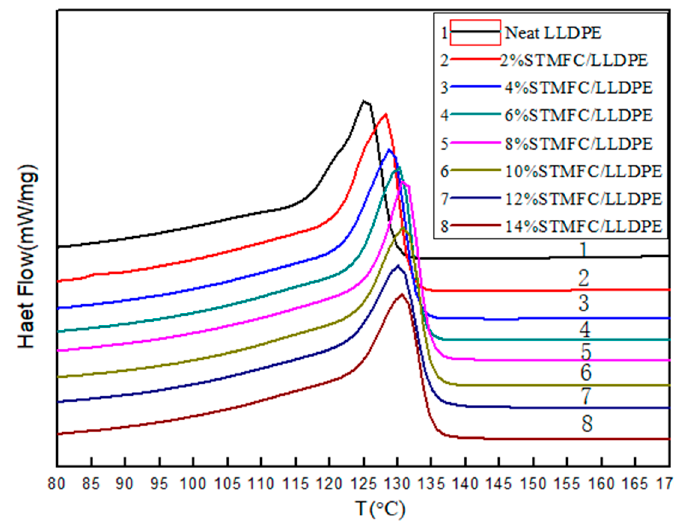
Figure 10. DSC melting curves of STMFC/LLDPE composites with different contents.